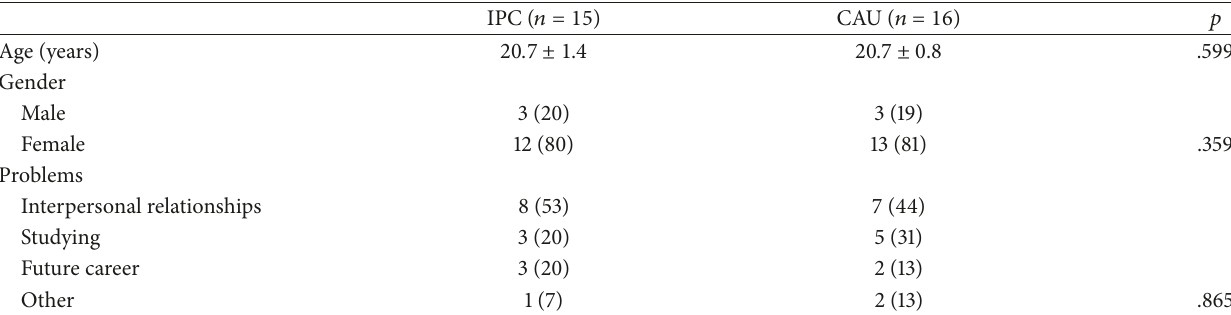
Table 1: Participant characteristics.